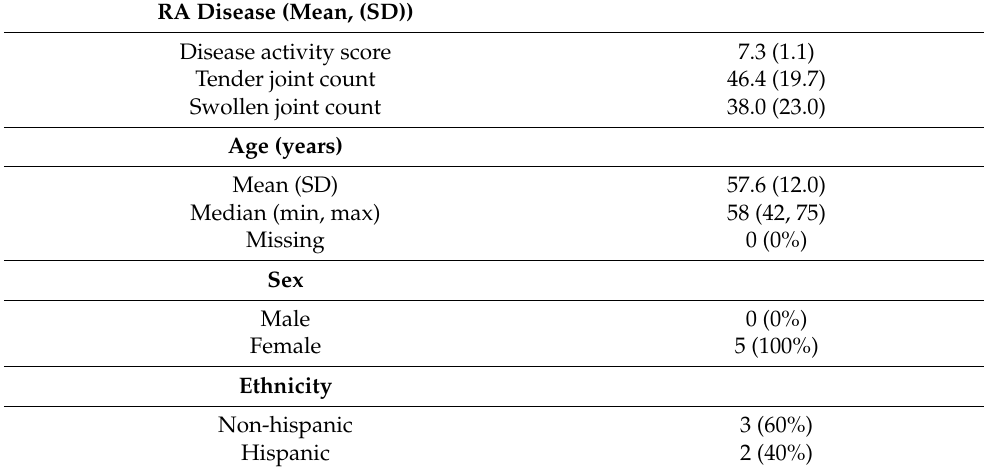
RA Disease (Mean,